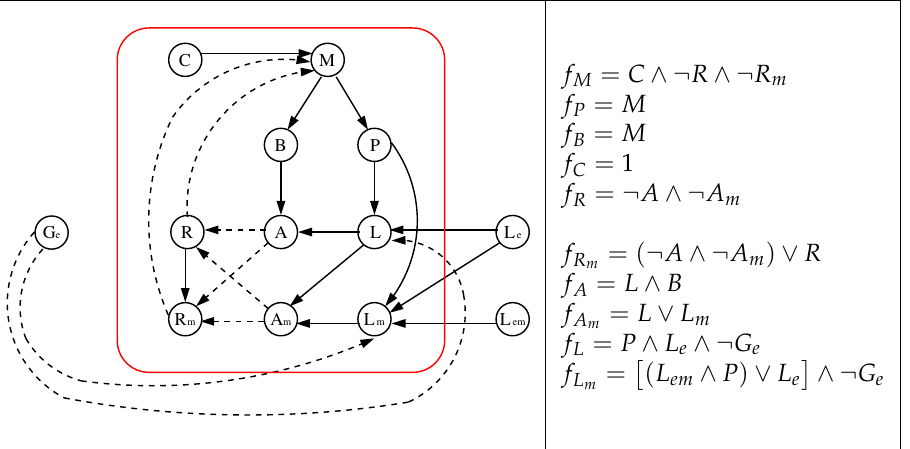
Figure 2. The original model of [20] ( left ) and its local Boolean functions ( right ). A solid (dashed) edge represents an activation (inhibition). We use the red box to differentiate the parameters of the model (outside) from its variables